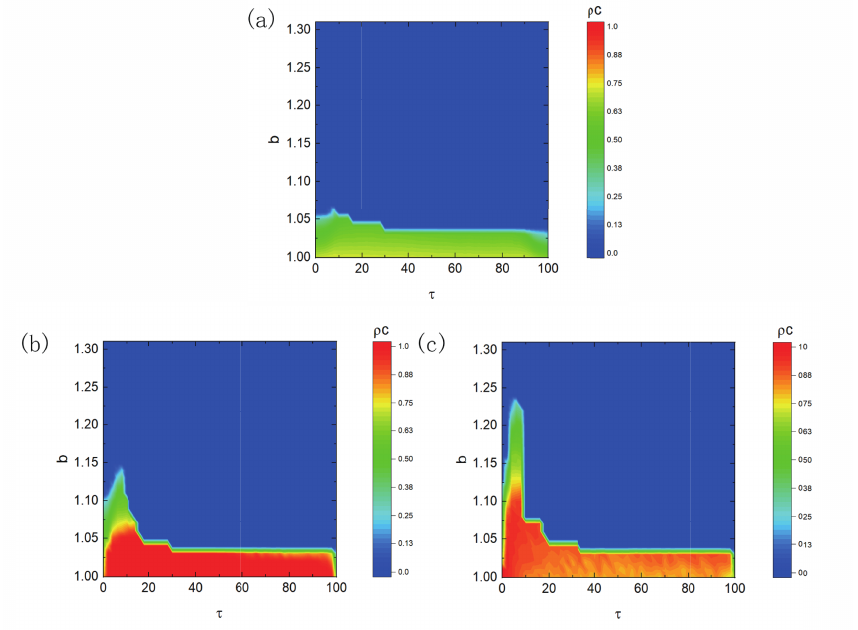
Figure 1. The b − τ plane encoding proportion of cooperation, ρ c under different coupled strength β . Due to the similar trend of the results obtained on both networks, only the results obtained on network A (bottom) are presented here. From subgraphs ( a – c ), the values of coupled strength β are 0.2, 0.5, and 0.8, respectively. Furthermore, for most data points, the MC is generated into 5 × 10 4 to ensure that the system reaches the equilibration state; while for some phase transition data points, the procedure executes 10 5 MC generations to guarantee that the system achieves the similar state. The remaining parameters are set to be L = 200 and K =